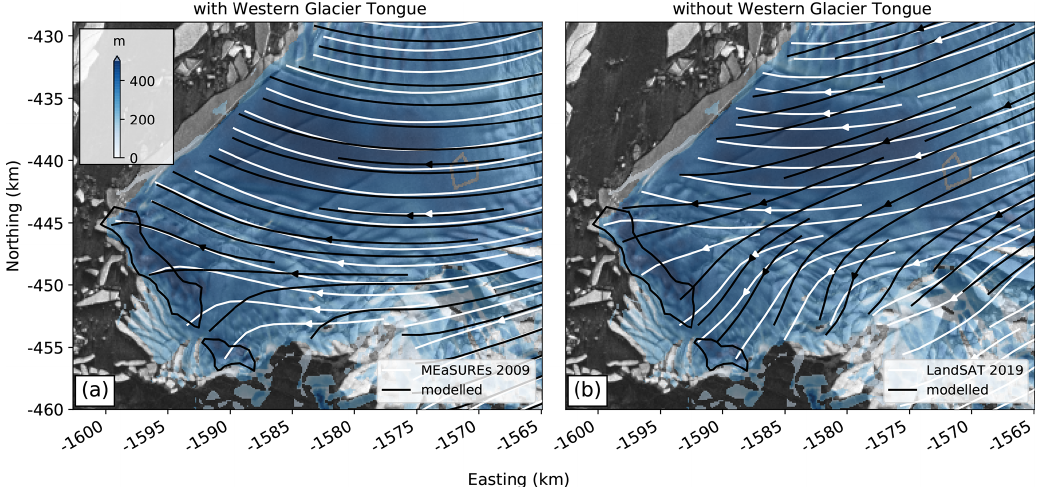
Figure 8. Comparison between (white) satellite-derived streamlines and (black) numerical solutions from ISSM: (a) the situation before the breakup of the Western Glacier Tongue in 2009 with a relatively well-grounded pinning point. (b) Removing the Western Glacier Tongue from the model domain, and thus weakening its influence on the Eastern Ice Shelf, reproduces the flow divergence around the pinning point as observed in the satellite data but overestimates the counterclockwise rotation of ice flow. This suggests that the Eastern Ice Shelf has not yet fully decoupled from the Western Glacier Tongue, particularly closer to the grounding line. Blue colors correspond to the ice thickness estimate derived in this